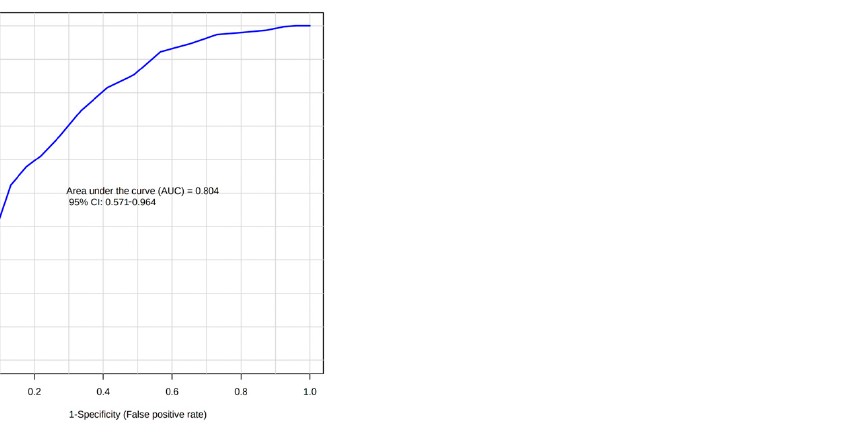
Figure 3. ROC curve derived from Random Forest discriminatory algorithm for binary system CG–AMR; as input data, the relative concentrations of plasma metabolites were used .